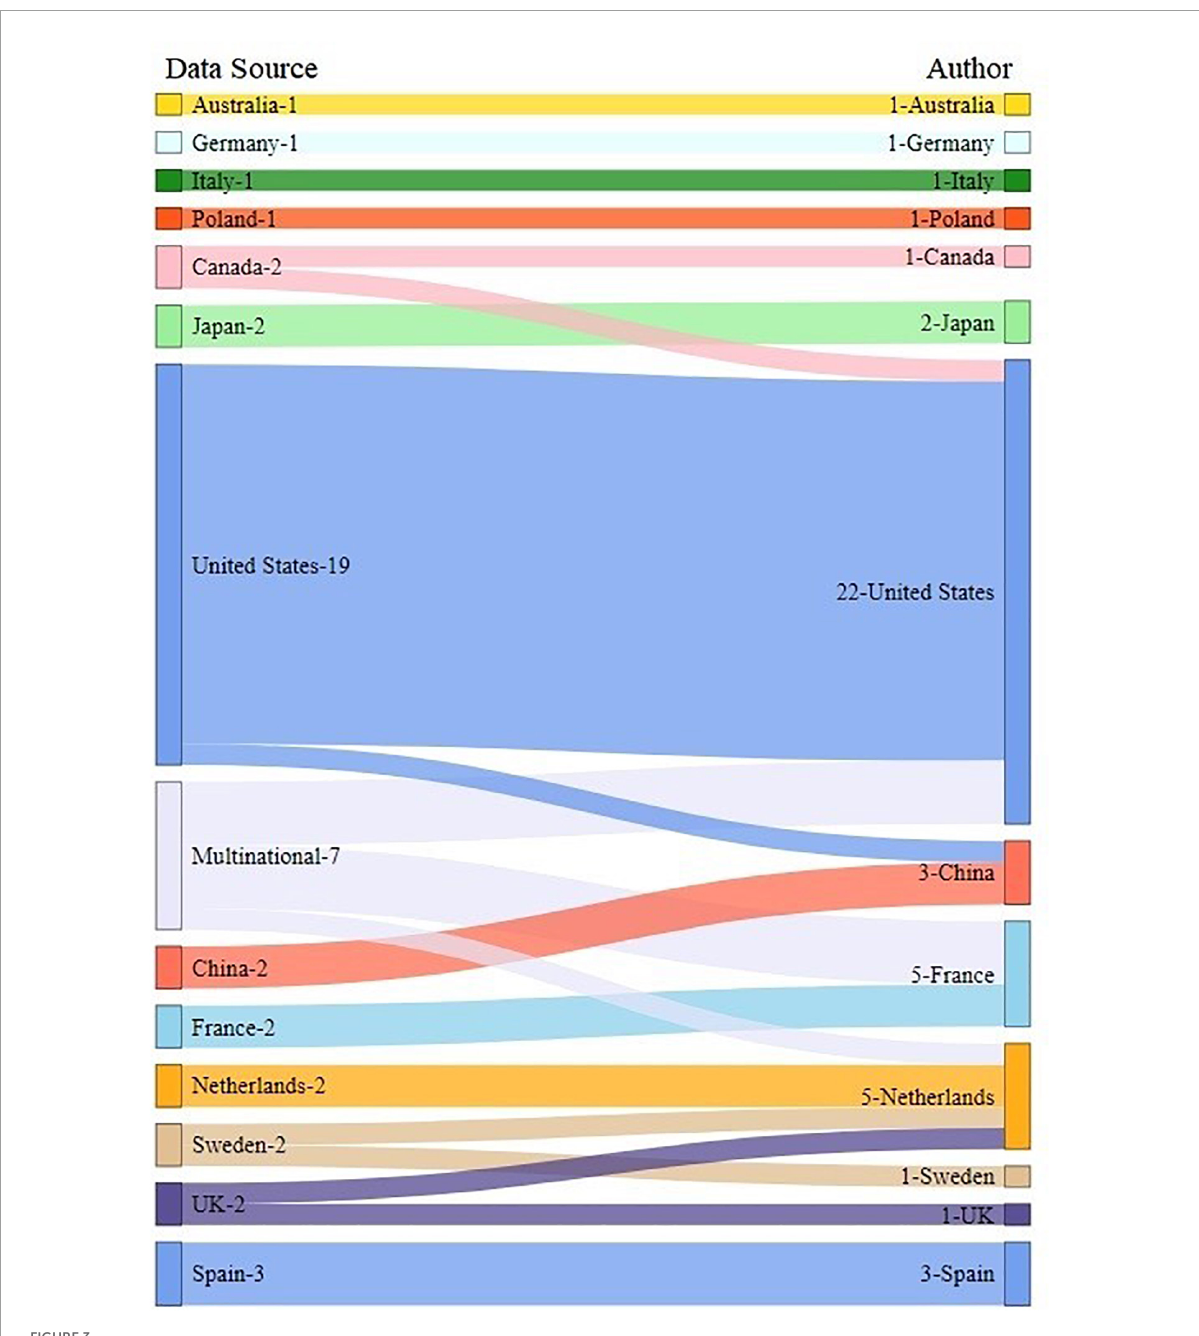
FIGURE3 Relationship between data sources and corresponding